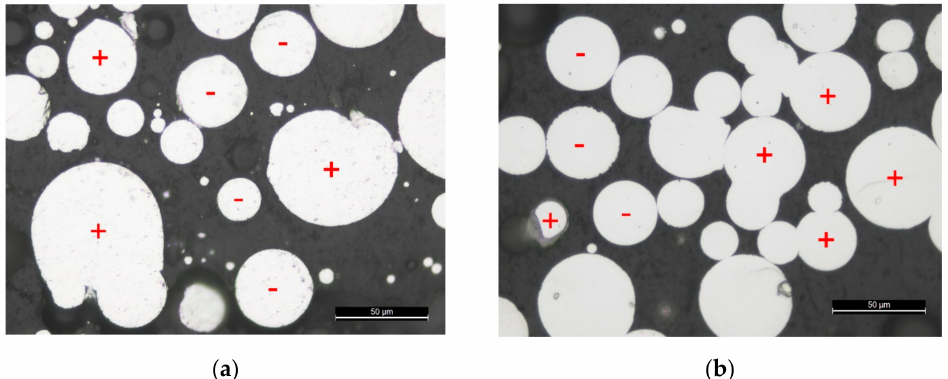
Figure 7. Two-dimensional (2D) morphological analysis of Ti6Al4V powder for the identification of spatter particles, within ( a ) 63 µ m sieve-captured powder and ( b ) 50 µ m sieve-captured powder. The plus symbol (+) represents spatter particles and the minus ( − ) symbol represents the desired particle geometry for Laser-based Powder Bed Fusion (L-PBF) process (Type